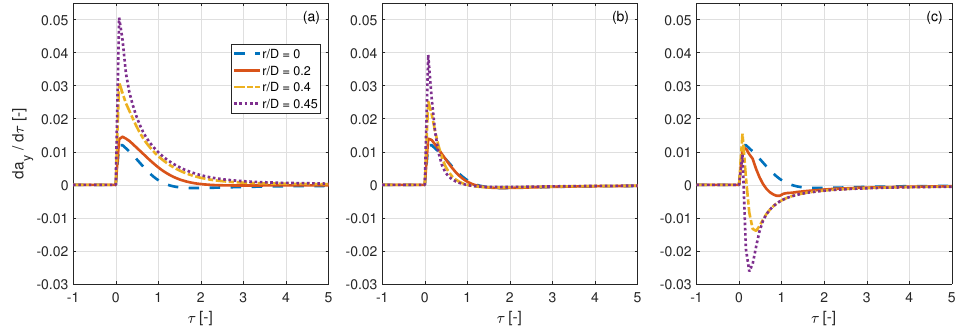
Figure 11. Time derivative of a y at different radial positions from CFD model when base C T = 0.6, step ∆ C T = +0.1, r/D = 0.4, ( a ) downwind part: θ az = 0 deg, ( b ) center part: θ az = 90 deg, ( c ) upwind part: θ az = 180 deg.